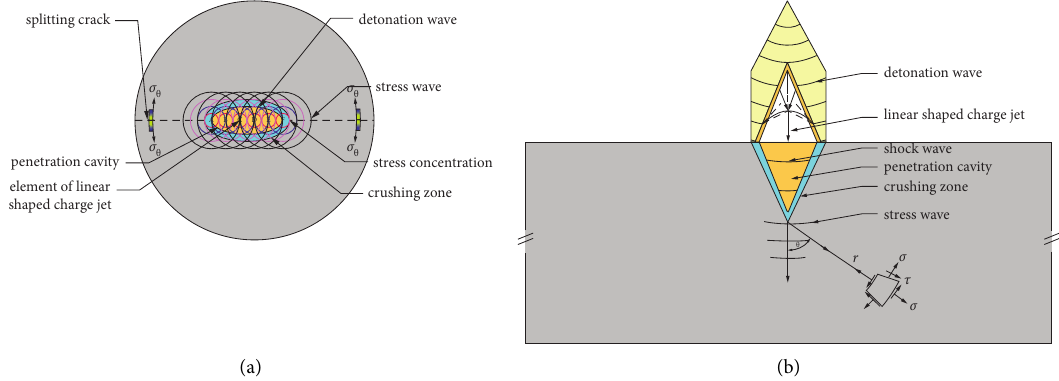
Figure 6: The crack tip is in the compound stress field.